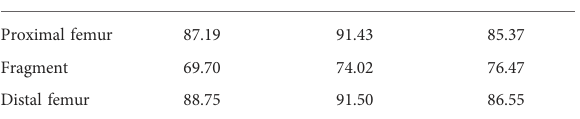
TABLE 3 Segmentation accuracy in 7 testing cases from the cross- dataset. Structures